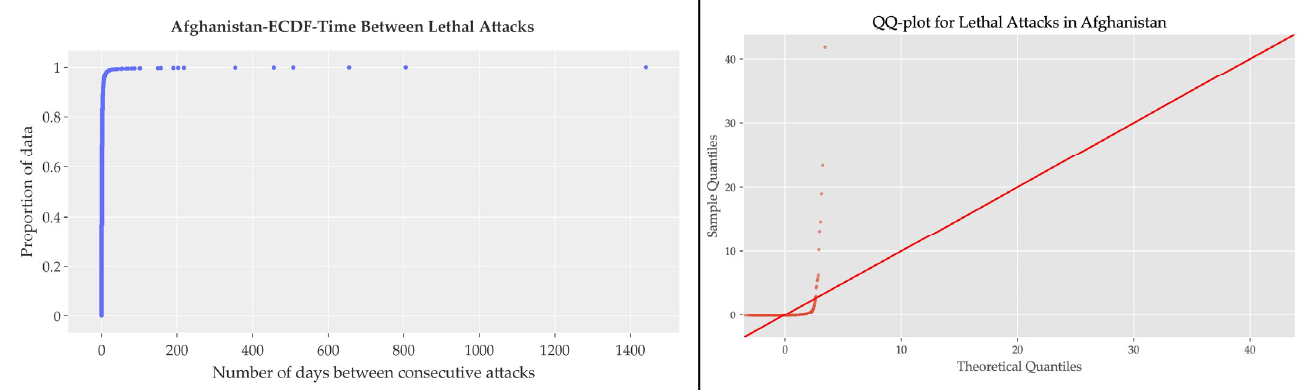
Figure 3. The time between consecutive lethal a tt acks and the corresponding QQ plot for Afghani- stan.